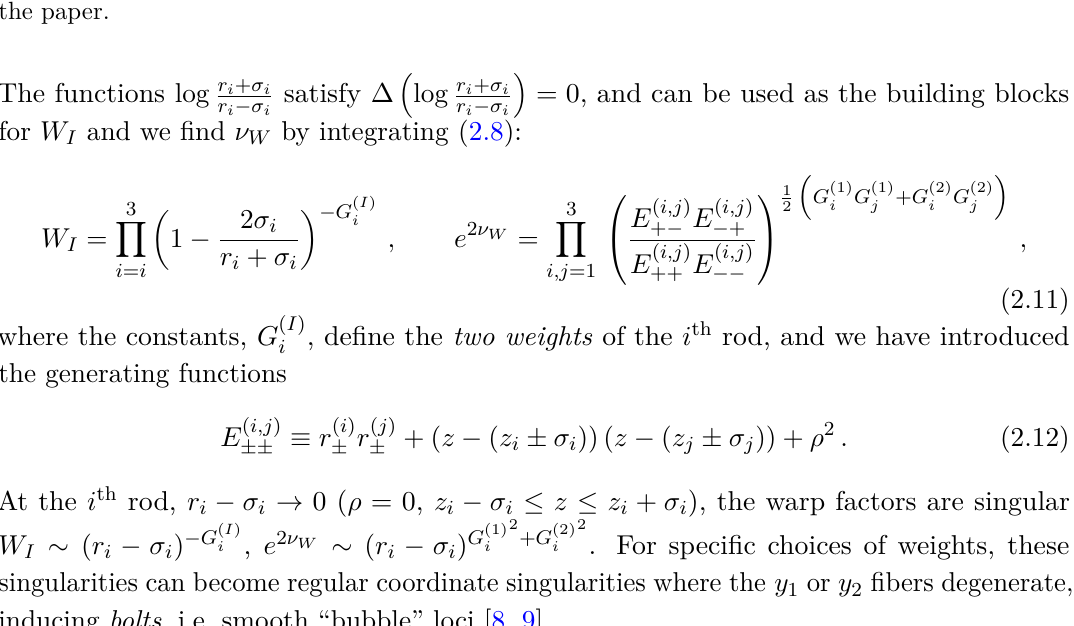
Figure 5 . Schematic description of the rod sources used to generate the three-body solutions in the